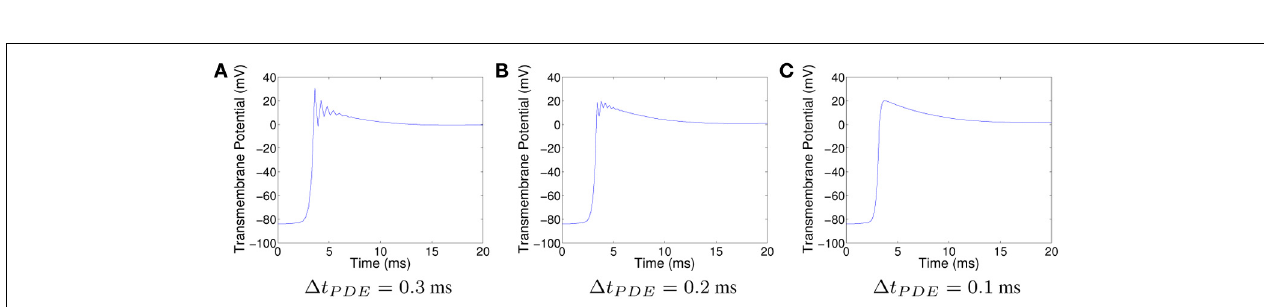
FIGURE 2 | Plots of the transmembrane potential on [0, 0.5] × [0, 0.25]cm at t = 8ms for Scenario I: (A) reference solution, (B) CN solution, (C) SDIRK2 solution, and (D) BE solution.